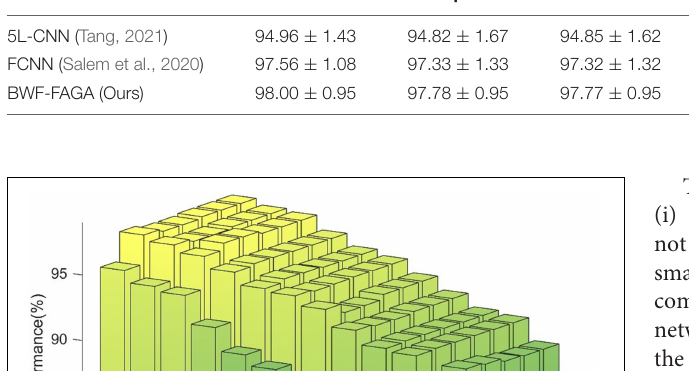
TABLE 8 | Comparison with DL-based MS recognition methods (unit: %). Method